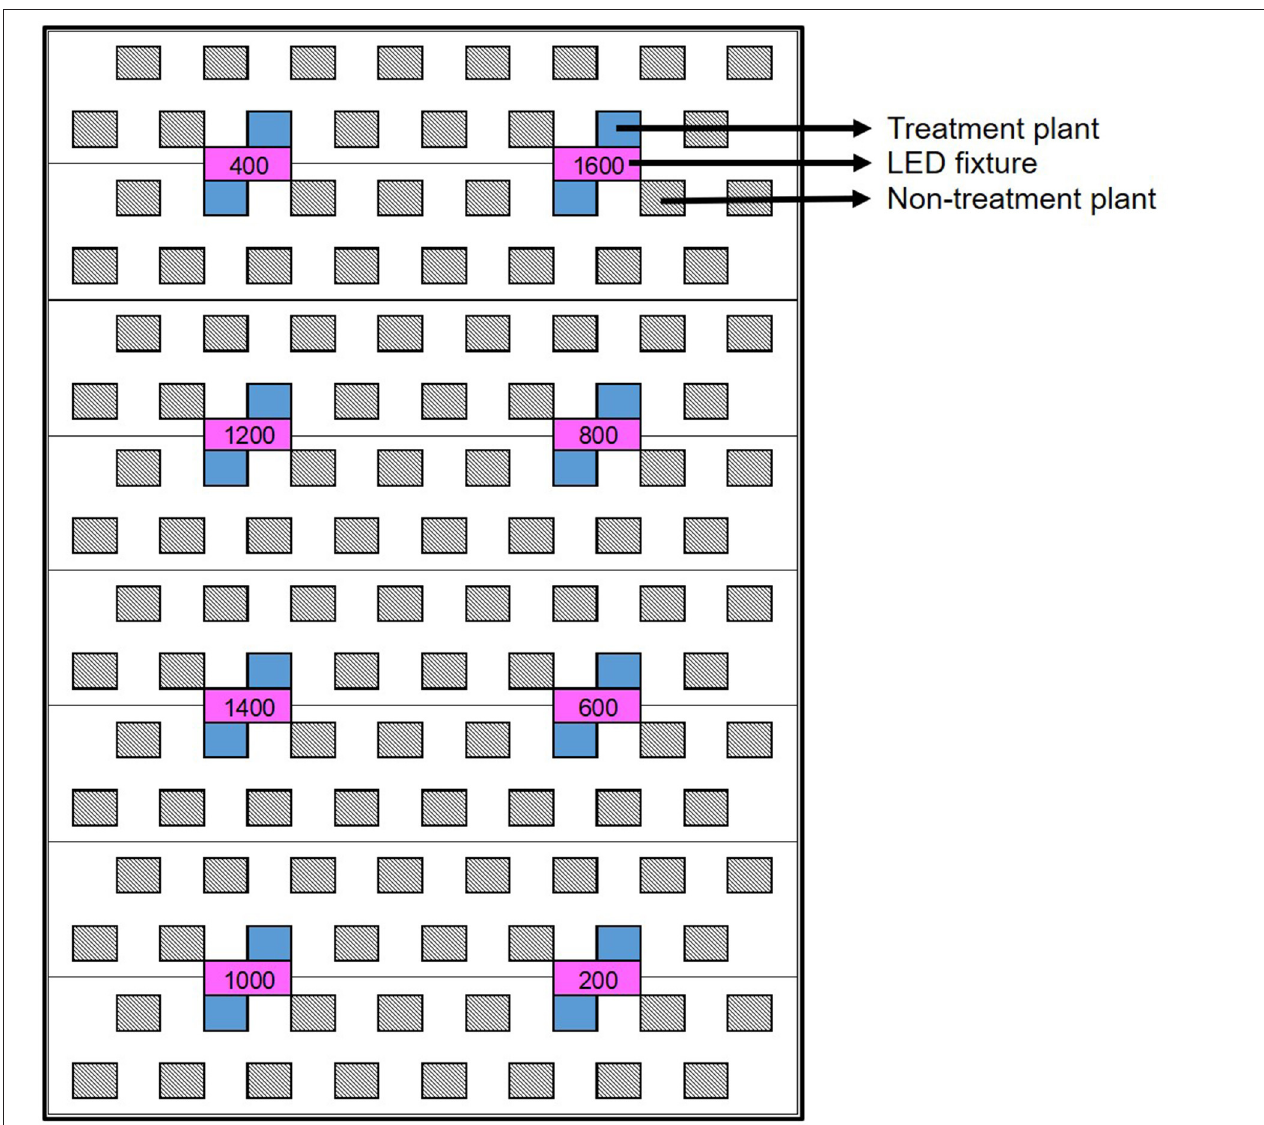
FIGURE 2 | Schematic of a single light rack (8 LED fixtures, in magenta) above one third of a deep-water culture basin (CB). The entire growing area consists of 6 of these light racks. Within each light rack, each of the 8 target PPFD levels (i.e., the “treatments”) are randomly assigned to one fixture (i.e., plot). This results in a RCBD- type of experimental layout, comprised of 8 treatments × 6 replications. However, each treatment plant (in blue) was assigned an average photosynthetic photon flux density (APPFD), reflecting the average canopy-level light intensity measured throughout the trial. The APPFD levels were used as the independent variable in subsequent analyses of plant growth, physiology and harvest metrics. Each plot was surrounded by non-treatment plants (diagonal lines) to ensure uniform growing environment and normal planting density.